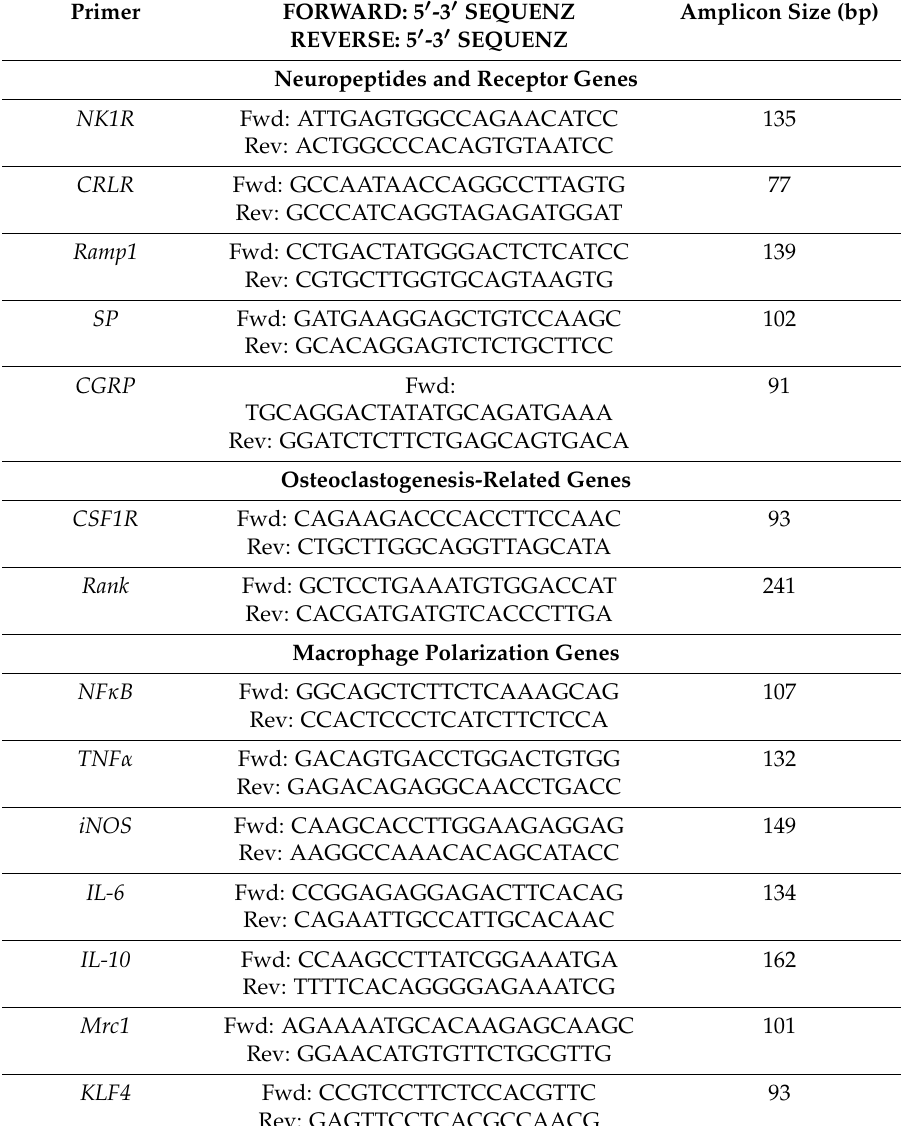
Table 1. The primer sequences used for quantitative real-time